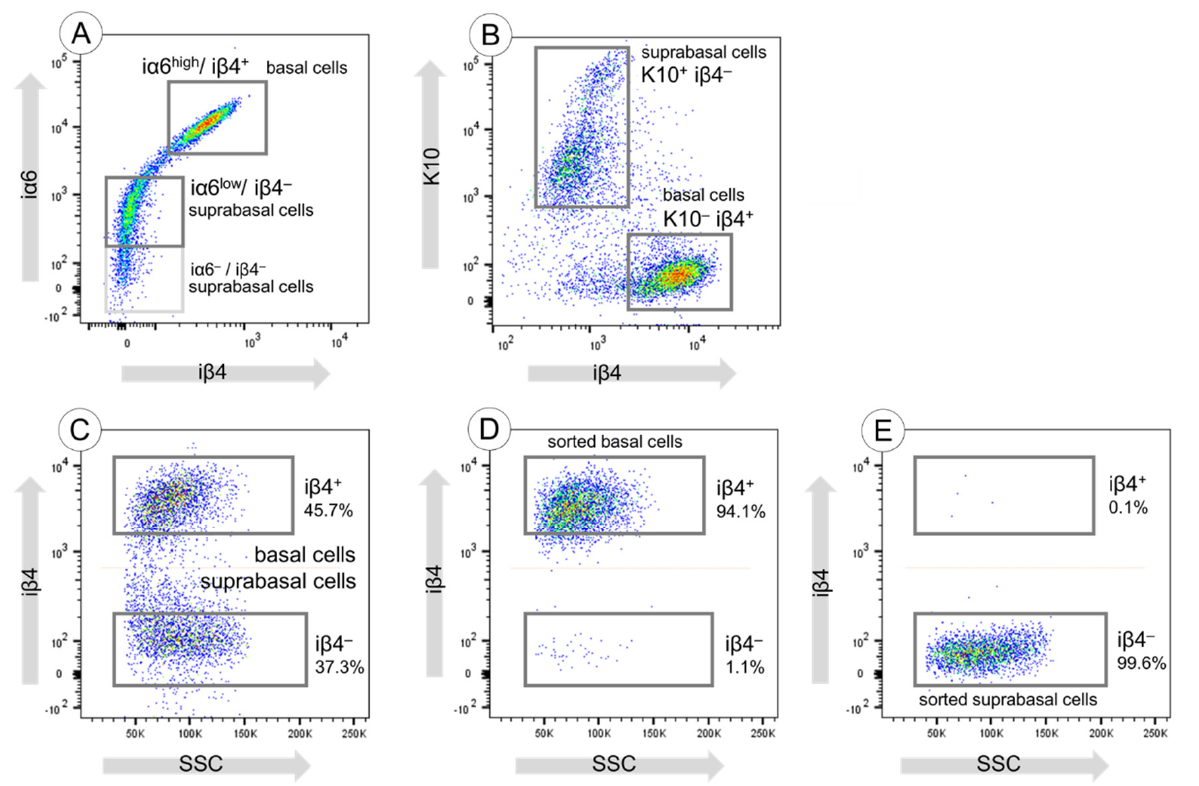
Figure 2. i β 4 expression discriminates basal and suprabasal keratinocytes. ( A ) Flow cytometry analyses of freshly isolated keratinocytes stained for i α 6 and i β 4 revealed the correlation between the i α 6 high and the i β 4 + population. ( B ) In the same way, co-staining of i β 4 and K10 demonstrated the inverse correlation between K10 and i β 4 expression which allowed the clear discrimination of suprabasal and basal cells. ( C ) FACS analysis and sorting of keratinocytes stained for i β 4 only. Two distinct populations were visible: basal i β 4 + and suprabasal i β 4 − keratinocytes. ( D ) Sorted i β 4 + population. ( E ) Sorted i β 4 −